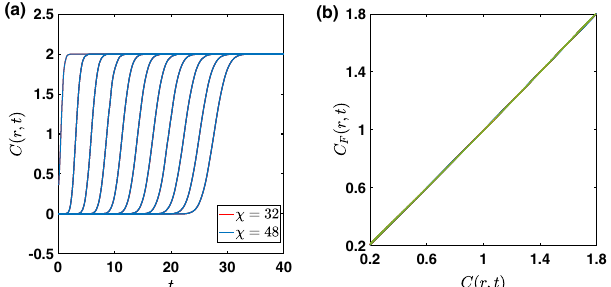
FIG. 8. (a) Up to N ¼ 10 spins in each cluster and L ¼ 200 clusters, the numerical data for the squared commutator converge excellently with the bond dimension of the S-MPS. Bond dimension χ ¼ 32 and bond dimension χ ¼ 48 give rise to almost identical results for all timescales. This result allows us to access the entire scrambling behavior from early growth to late-time saturation. (b) Near the wave front, C ð r; t Þ perfectly r;t Þ ¼ 1 þ erf ( ð v t − r − r 0 Þ = ffiffiffiffiffiffiffiffi agrees with the fitting function C B fit ð p 4 Dt ) for all N